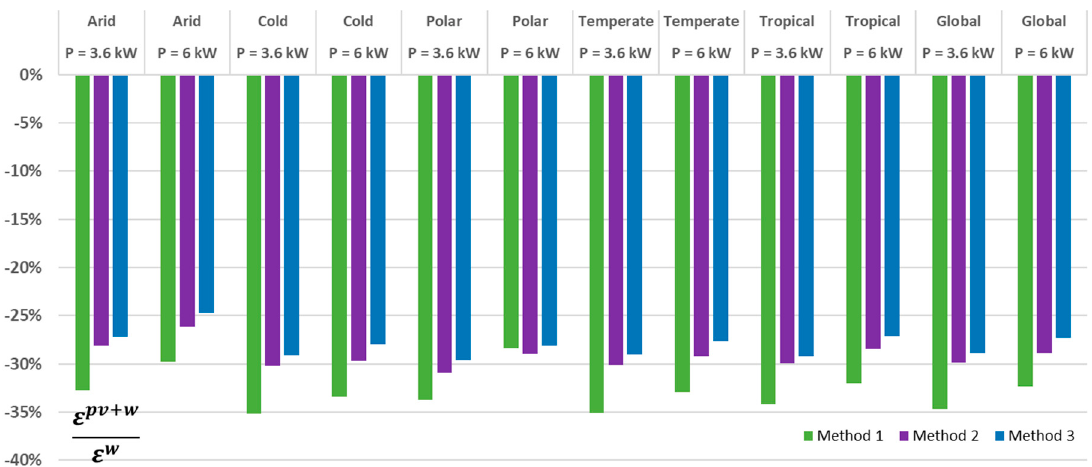
installed power capacity.